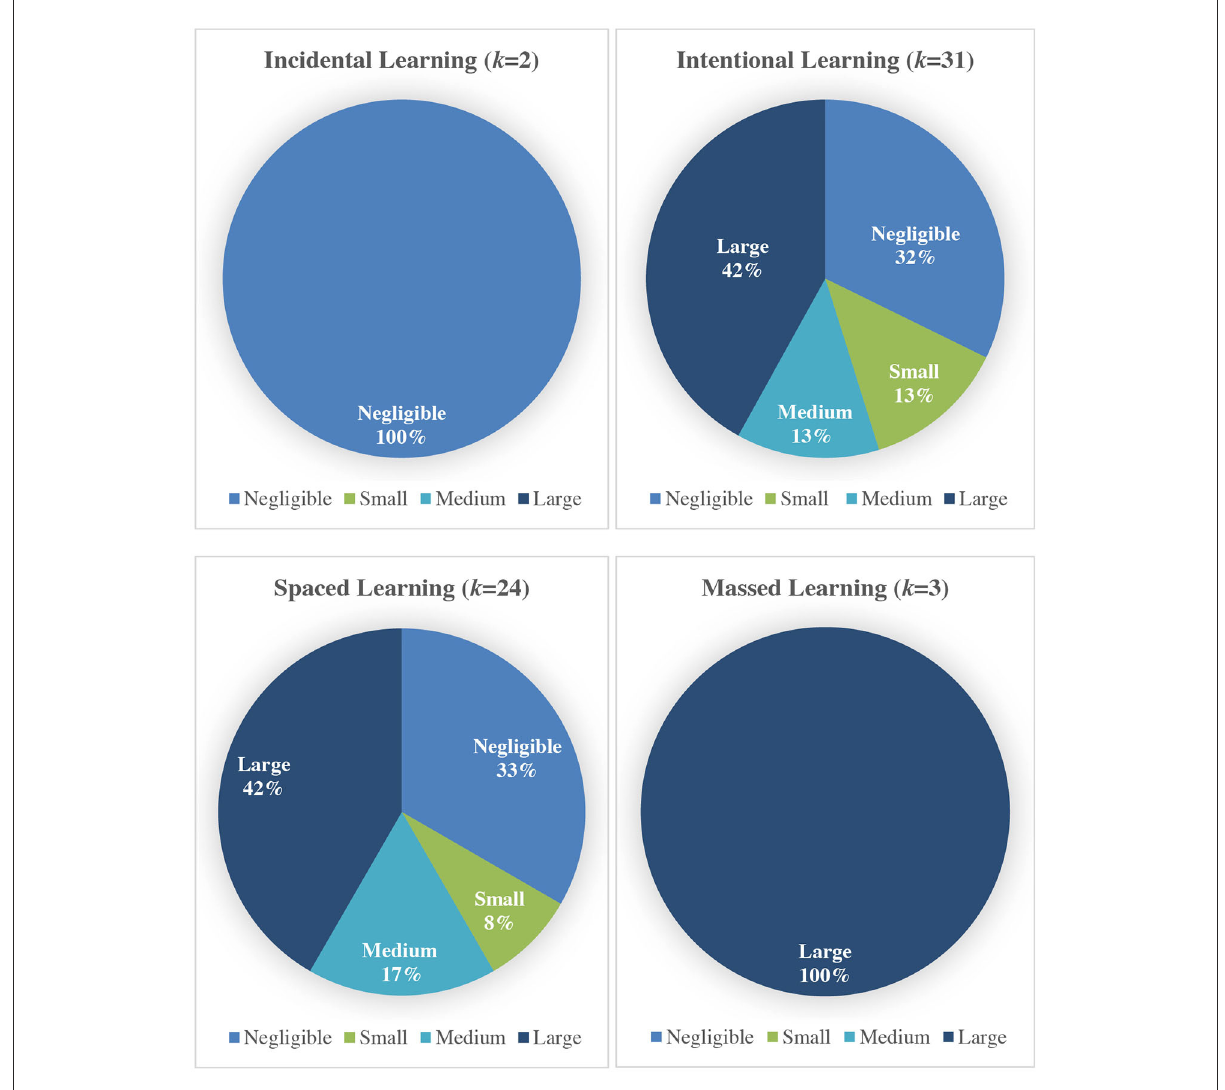
FIGURE5 Effect size plot for learning conditions ( k